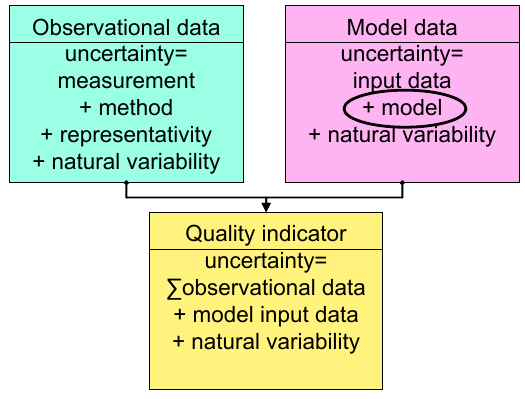
Fig. 3. Sketch, showing the components of model and observa- tional data and the consequences for the uncertainties of the quality